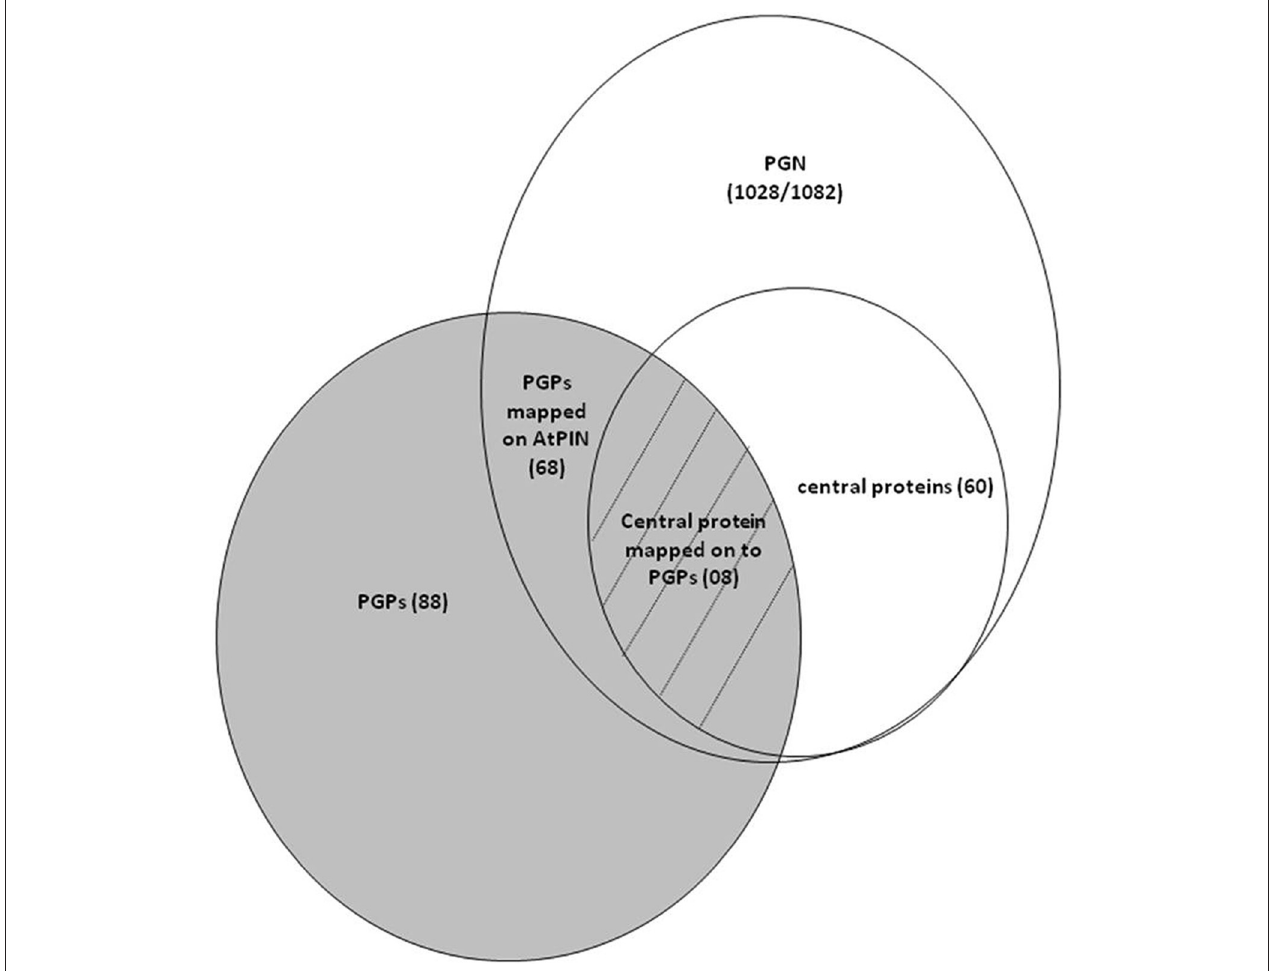
( Figure 2 and Table 2 ). We looked for the regulatory